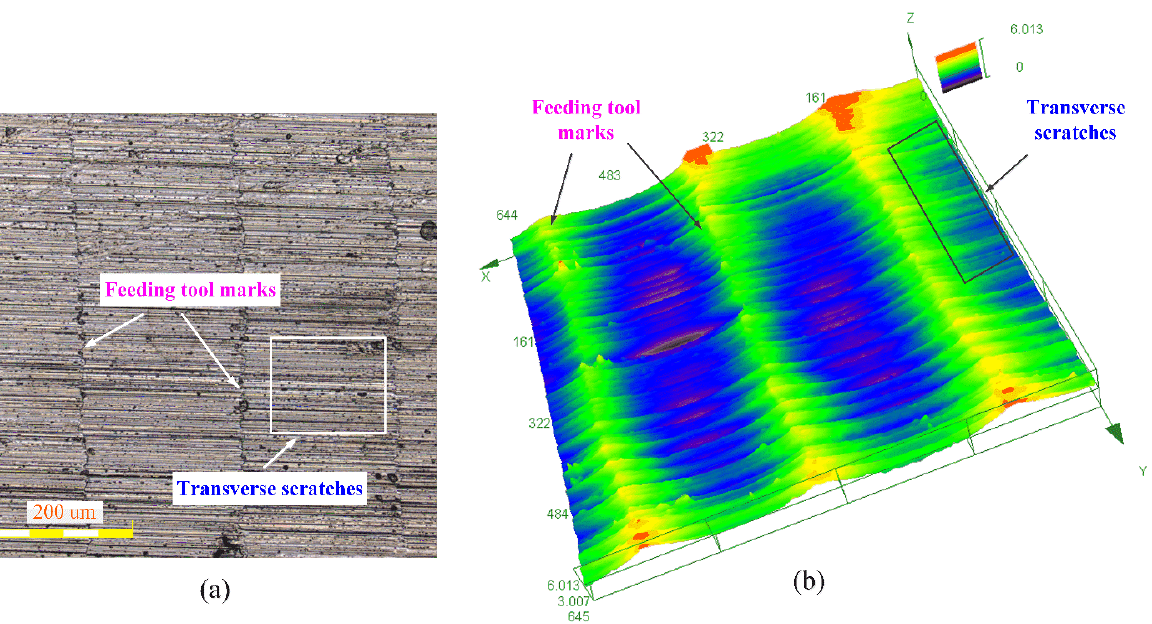
Figure 4. Feeding tool marks and surface scratches: ( a ) two-dimensional topography; ( b ) three-di- mensional topography.